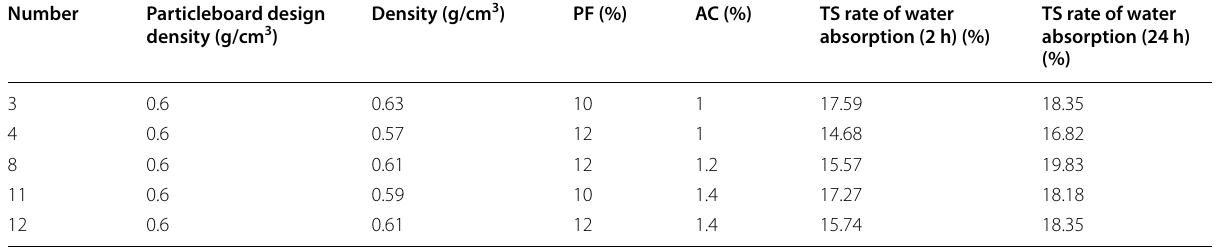
Table 3 The mechanical properties meet the thickness swelling rate of water absorption of different proportions under